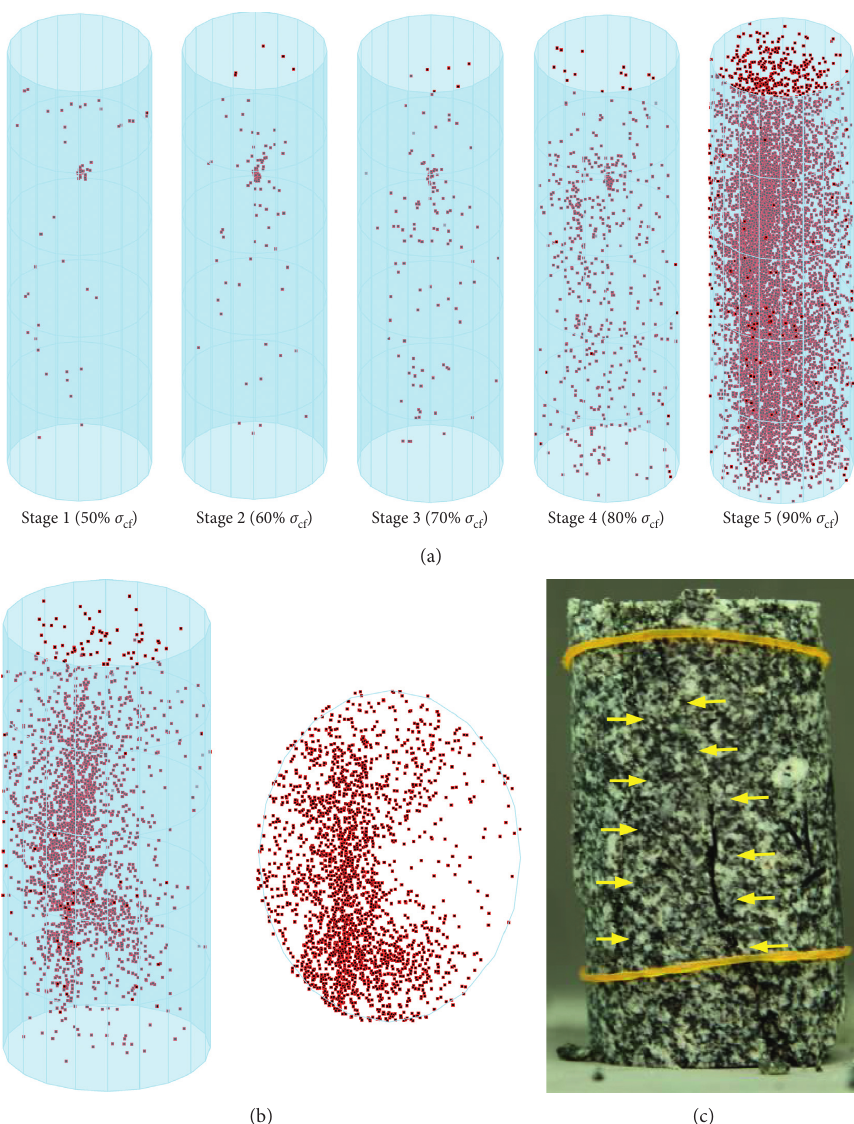
Figure 9: AE spatial distribution and failure pattern of unloading-cracked specimen at low confinement (specimen U1, σ AE spatial distribution at different creep stages. (b) AE events at the last stage with amplitude > 45dB. (c) Failure